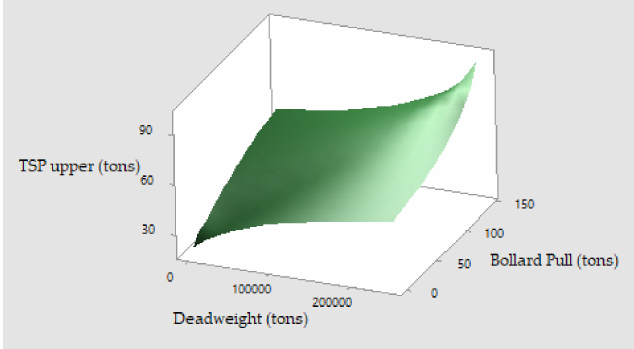
Figure 10. Surface graph for IMO TSP upper